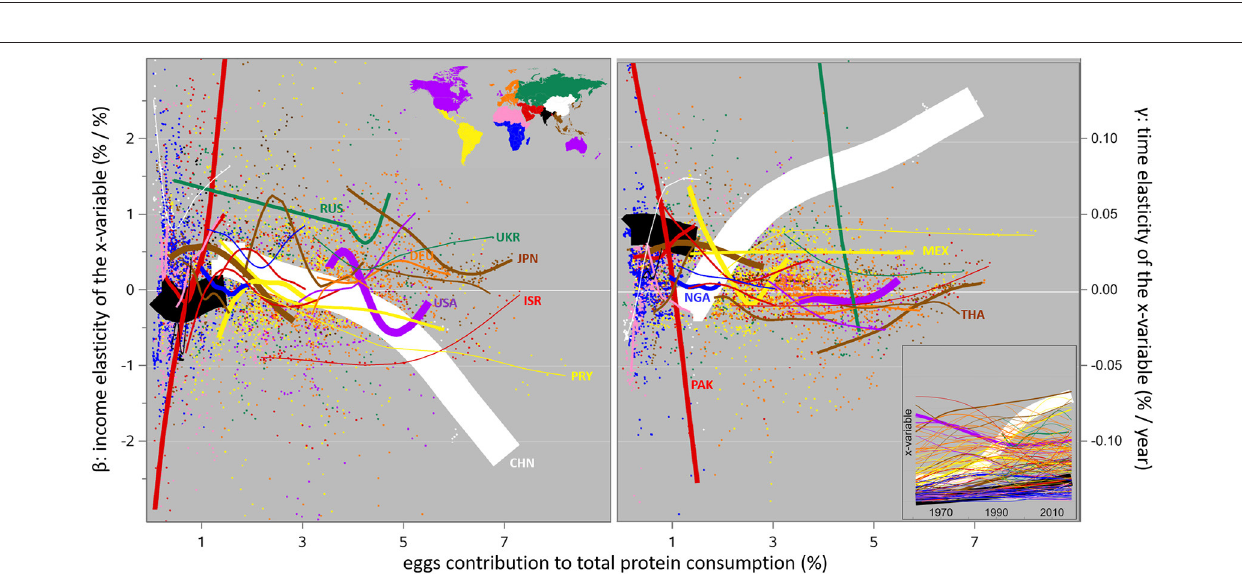
FIGURE 10 | The same relations as in Figure 8 , for